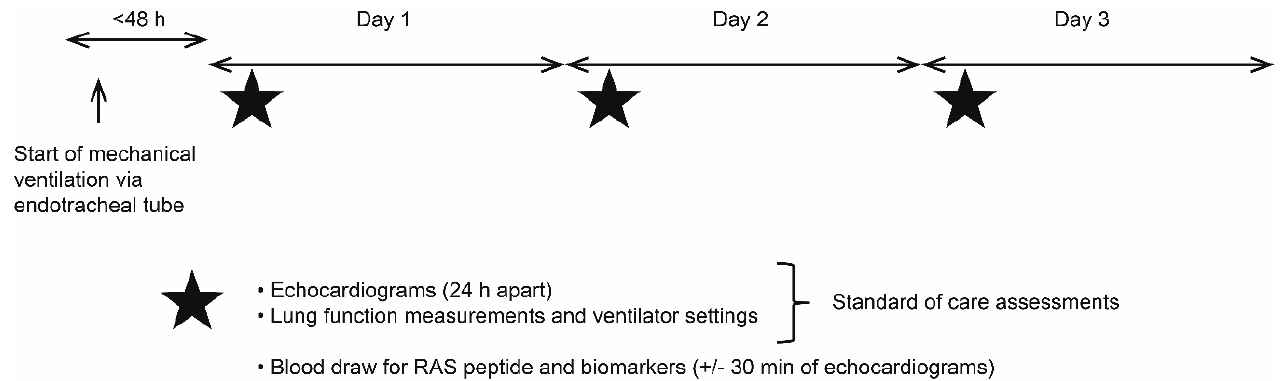
Figure 1. Study design and key study features. h , hours; RAS , renin-angiotensin system.